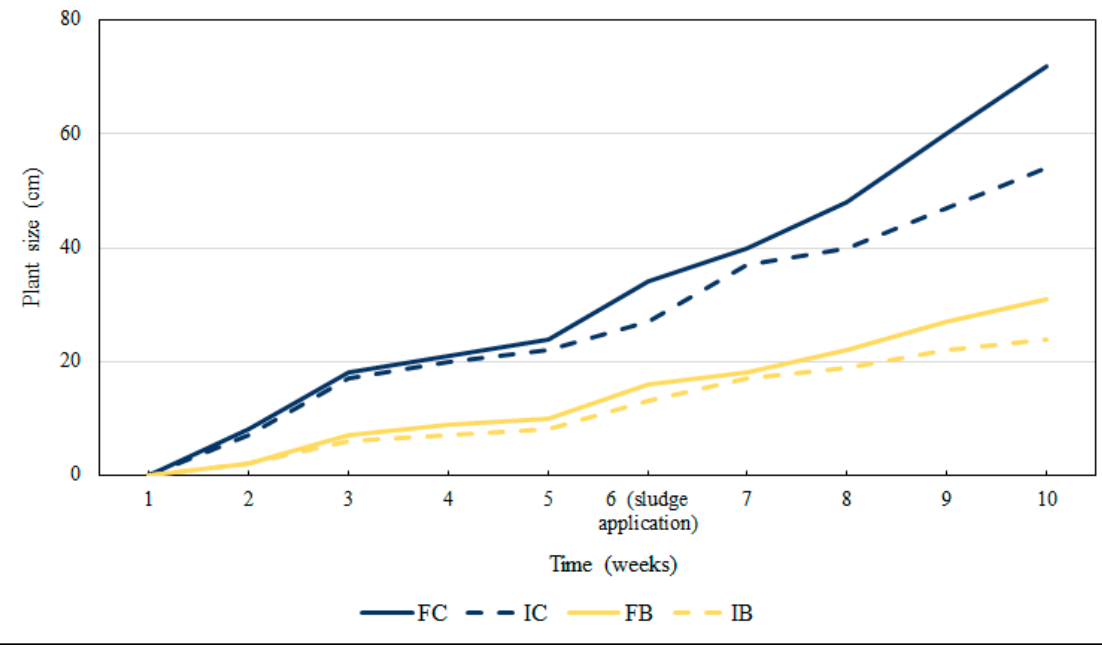
Fig. 2 Crop growth analysis relative to time (repeats average) and the type of technique applied IB = irrigated bean; FB = fertigated bean; IC = irrigated corn; and FC = fertigated corn. Crop microbiological quality